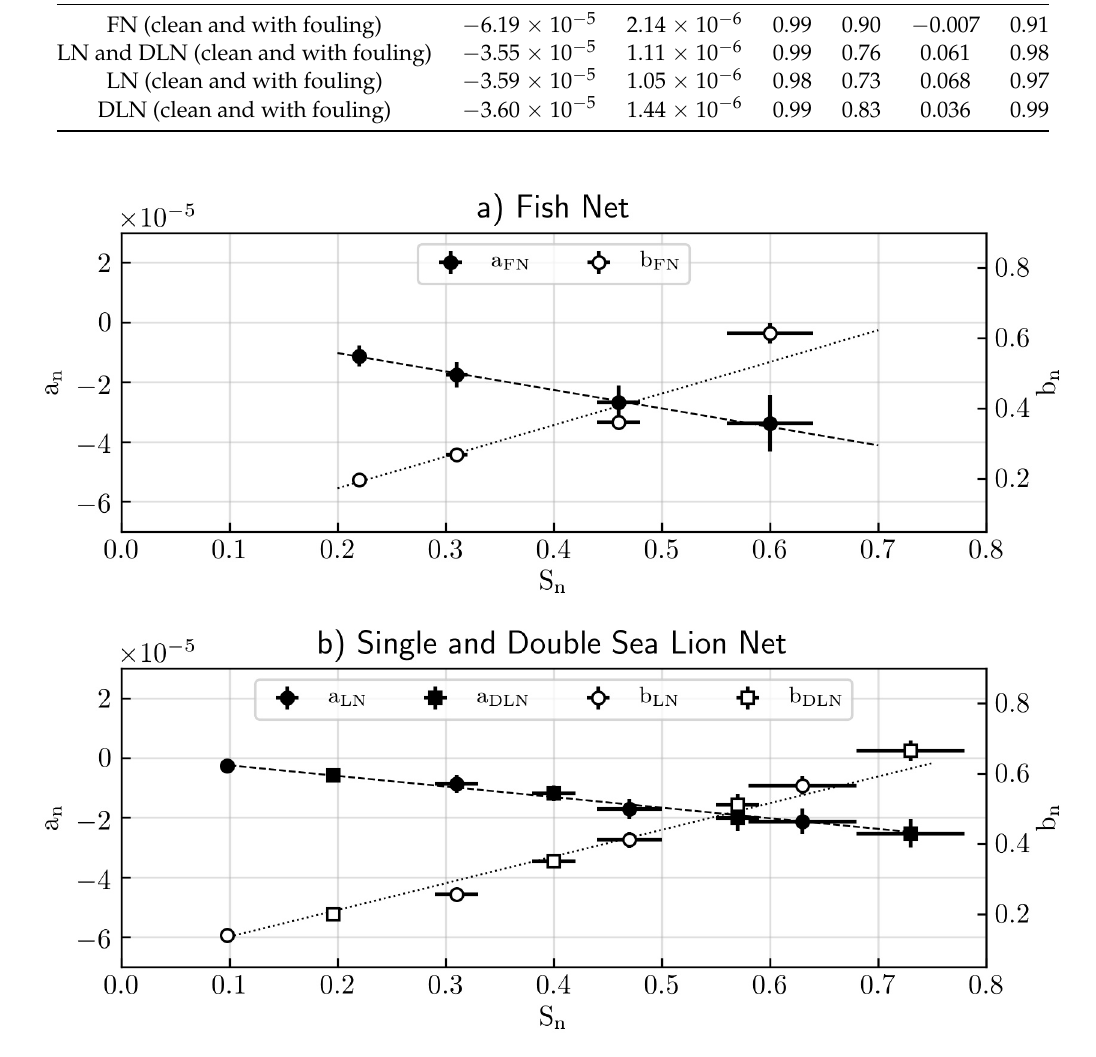
Figure 9. Coefficients a and b of the linear fit with Reynolds numbers of the normal drag coefficient for ( a ) fish net and ( b ) double and single sea lion nets as a function of the solidity index. Experimental series, clean or without fouling, from Table 1. Dashed lines represent a linear fit of the